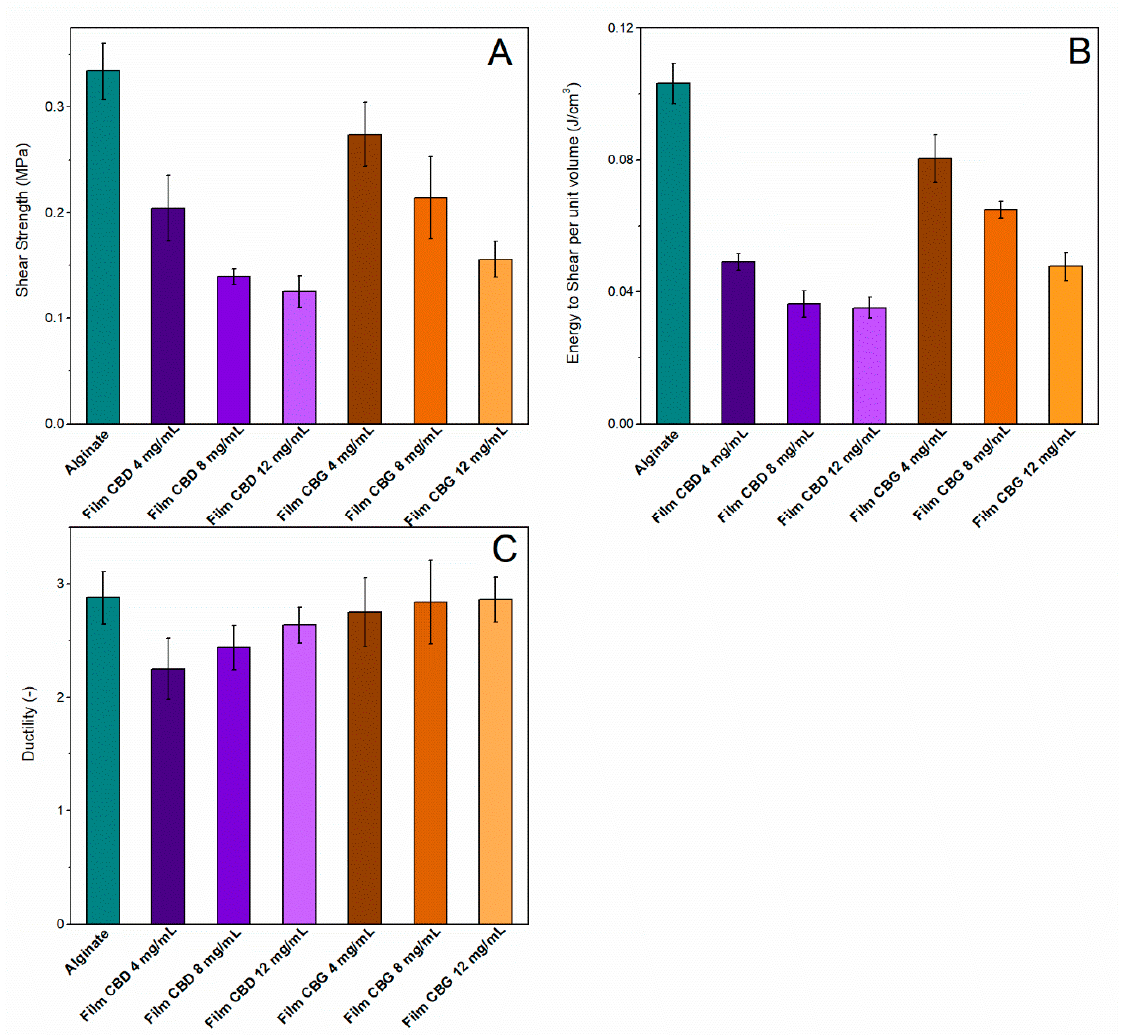
Figure 5. ( A ) Shear strength, ( B ) Energy shear per unit volume and ( C ) Ductility of the loaded and unloaded films.